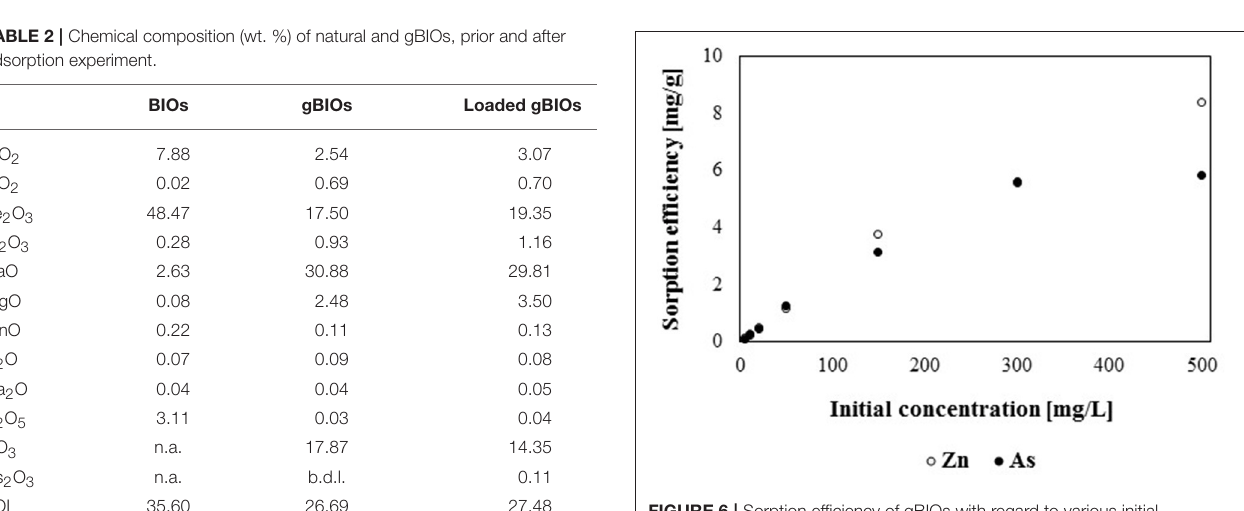
FIGURE 6 | Sorption efficiency of gBIOs with regard to various initial concentration of As and